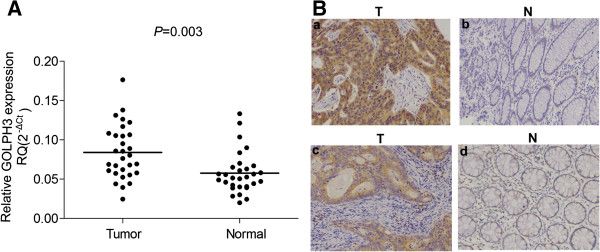
Expression of GOLPH3 in colorectal tissues. (A) GOLPH3 mRNA level in CRC tissues (Tumor) and matched adjacent noncancerous tissues (Normal) was detected by qRT-PCR. The relative expression of GOLPH3 was normalized with GAPDH mRNA level. (B) Representative immunohistochemical images indicate strong (a) or moderate (c) GOLPH3 staining in CRC tissues (T), and (b and d) staining of GOLPH3 in matched noncancerous tissues adjacent to tumors (N). Magnification is 200 × .